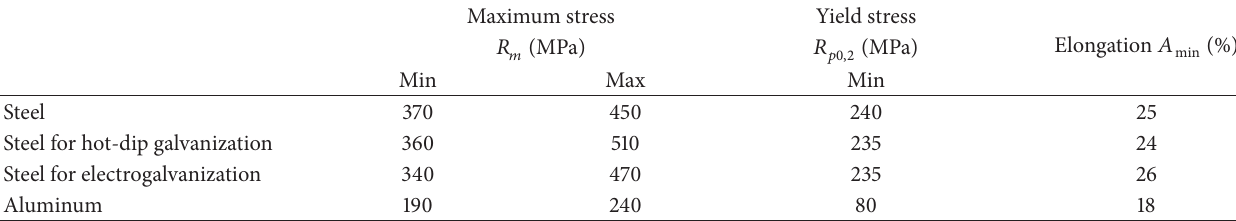
Table 2: Mechanical properties of the used